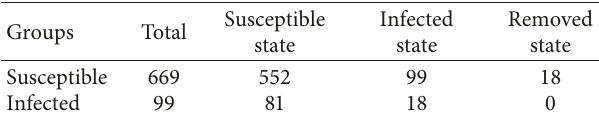
Table 3: Number of individuals at any state for TB at the end of the period.